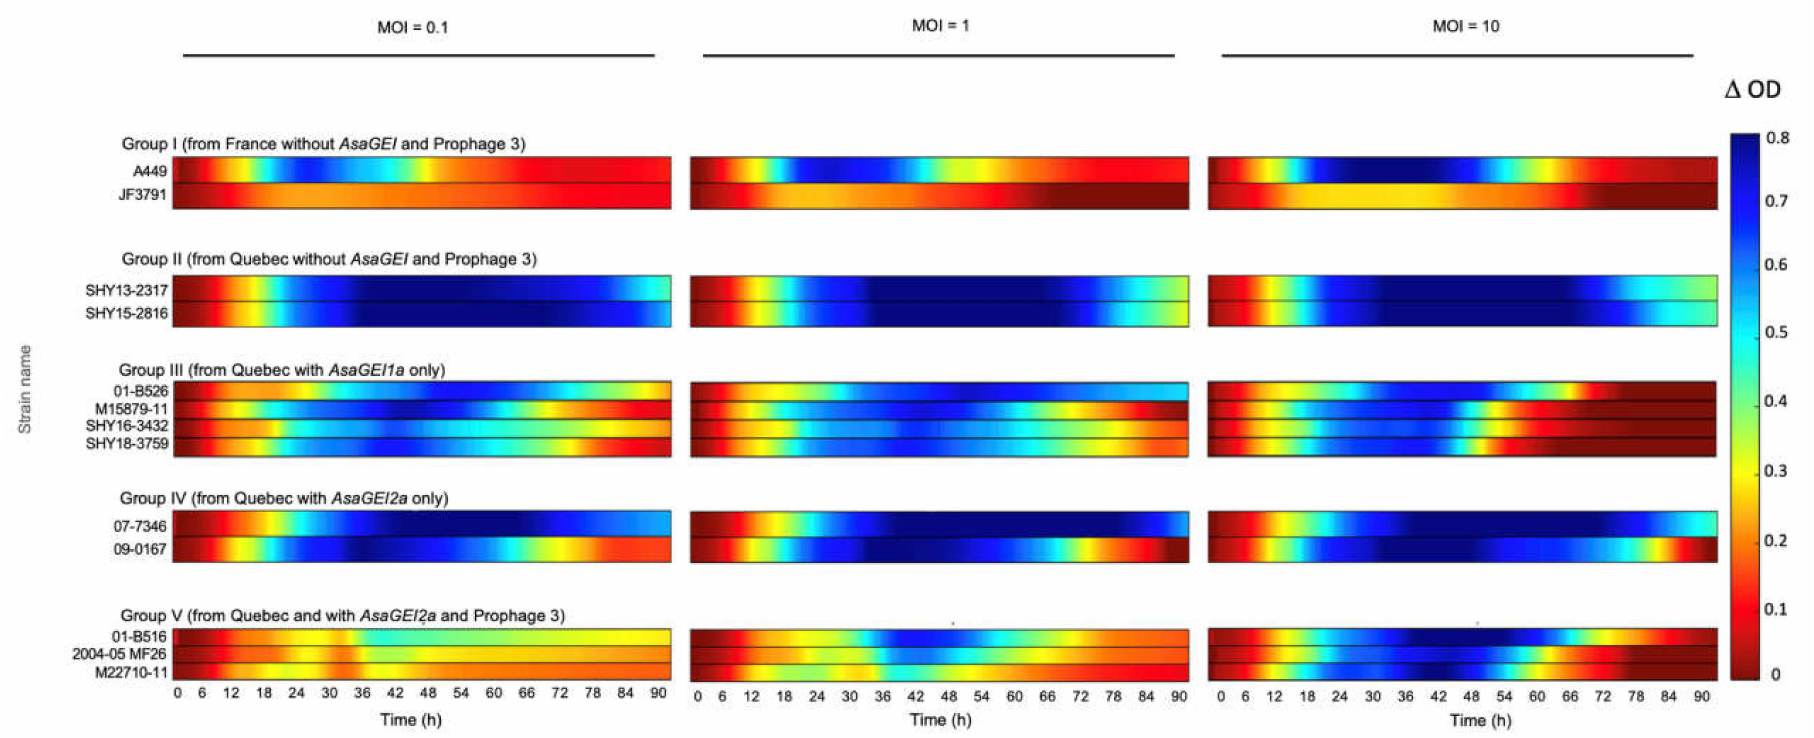
Figure 3. Effect of the phage cocktail T on the growth of various A. salmonicida subsp. salmonicida strains with different genetic backgrounds. Bacteria were incubated with the phage cocktail at different initial MOIs (0.1, 1, and 10) from left to right. The colored lines representing the growth inhibition by phages have been deduced as shown in Figure 1. When the bacterial growth is highly inhibited, the color of the line will tend to blue. No inhibition corresponds to red lines. The bacterial growths with the phage cocktail at MOI of 10 are especially obvious for strains in Groups I, III, and V after 54 h. In addition, bacterial growth is noticeable for Group V during the exponential phase approximately around 30 h for MOIs 0.1 and